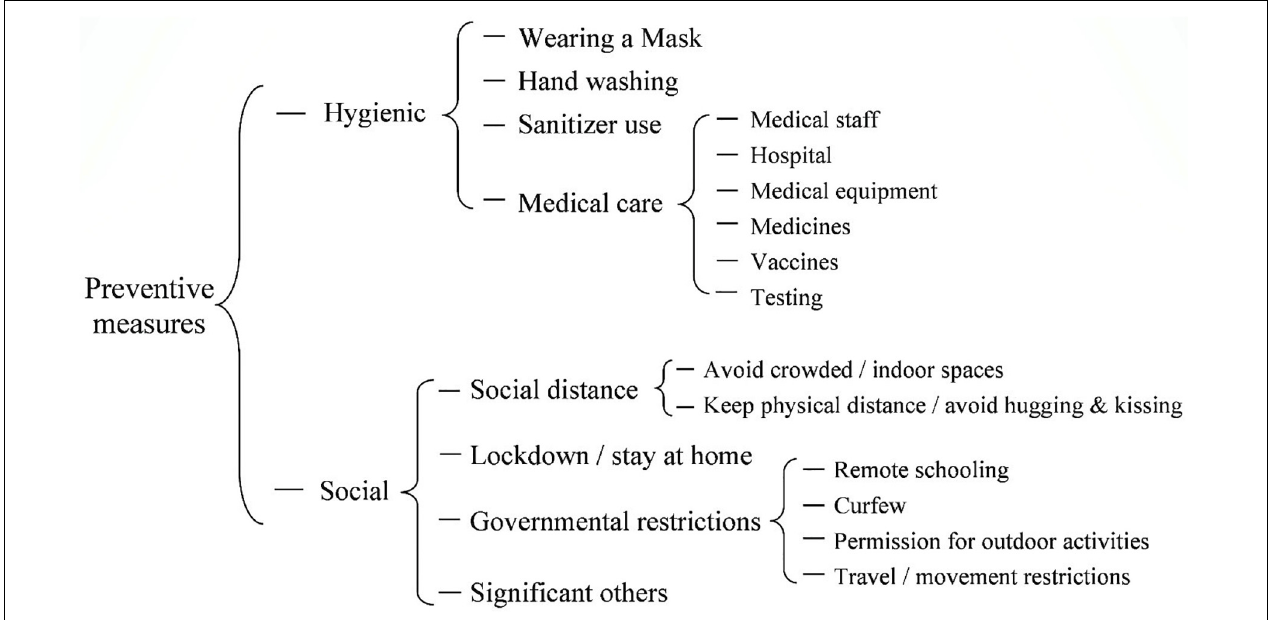
FIGURE 1 | Categories of hygienic and social preventive measures proposed by